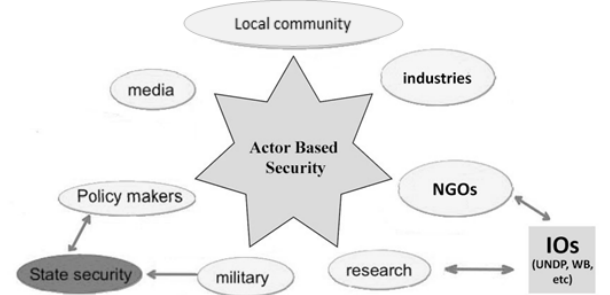
Figure 1. Actor-based security model adapted from